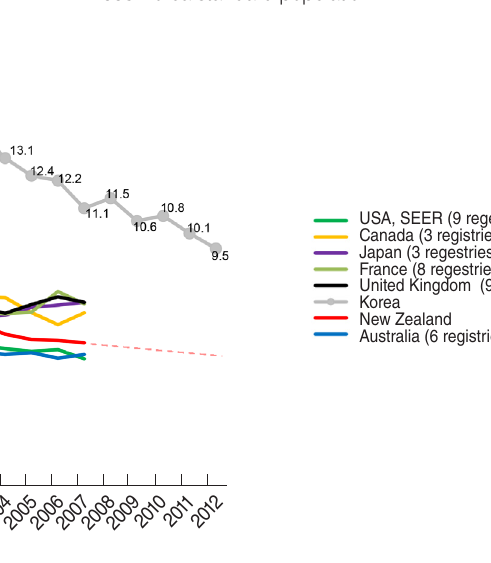
Figure 2. Trends in age-specific incidence rates of cervical cancer by birth cohort group in Korea, 2000, 2005 and 2010. Source from Korean Statistical Information Service. Number of cancer patients, relative frequency, crude rate, age-adjusted incidence by cancer site and sex from 1999 to 2011; 2014 [25]. 1 Age-adjusted to the 2005 Korea standard population.